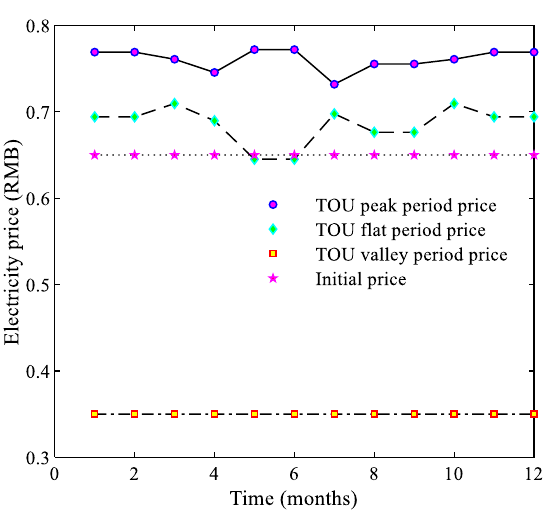
Fig. 7 Optimal results of TOU electricity prices